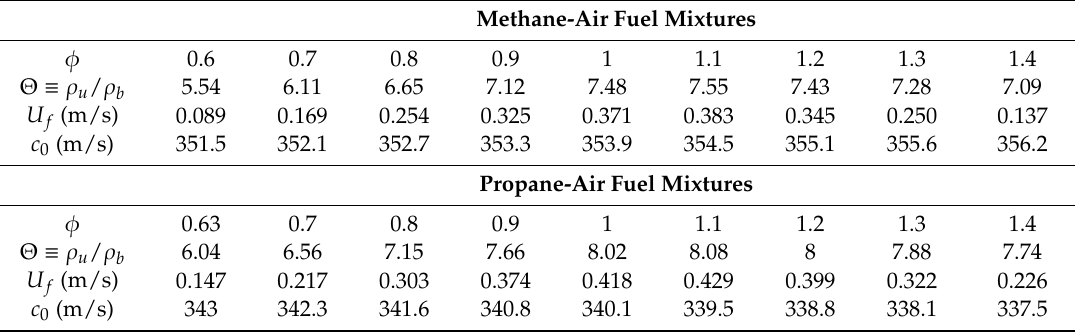
Table 1. The parameters for methane-air and propane-air combustion: the thermal expansion ratio, Θ , the laminar burning velocity, U f , and the sound speed in the fuel mixture, c 0 , versus the equivalence ratio, φ